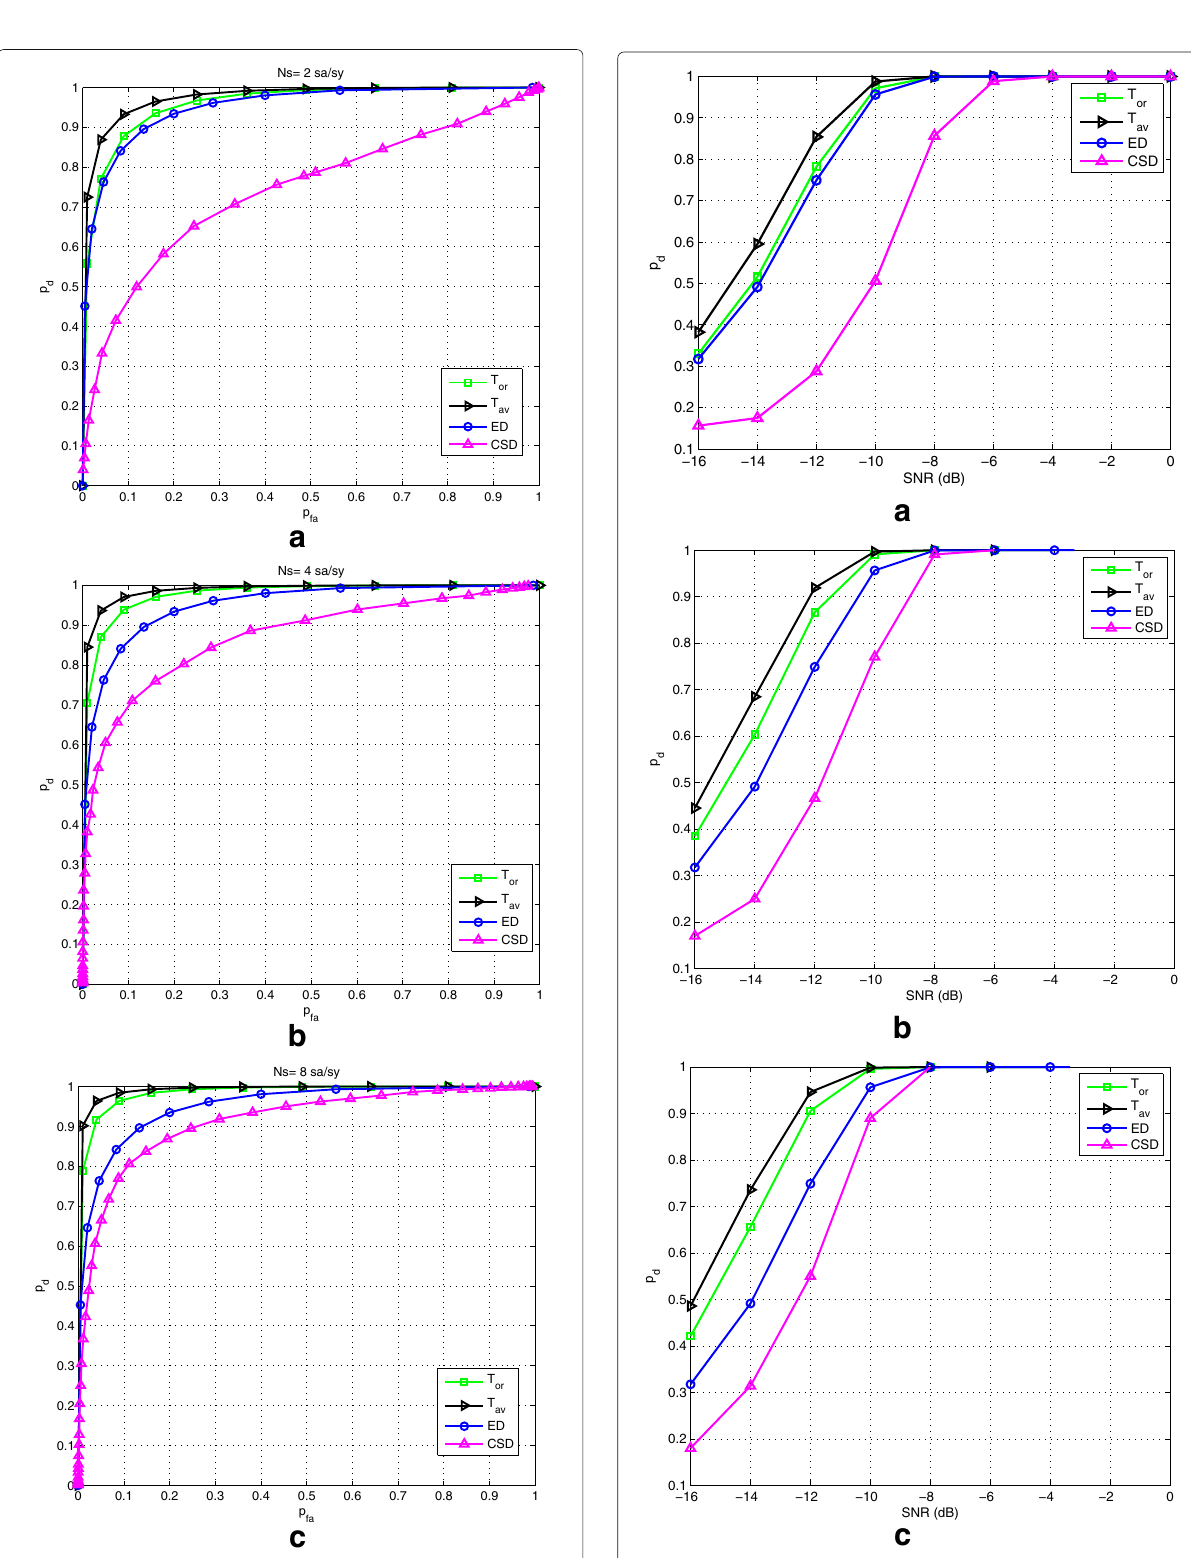
Fig. 5 ROC curves of our proposed detectors comparing to ED and CSD for various N s , SNR of -12 dB and N = 1500 samples. a N s = 2 sps. b N s = 4 sps. c N s = 8 sps